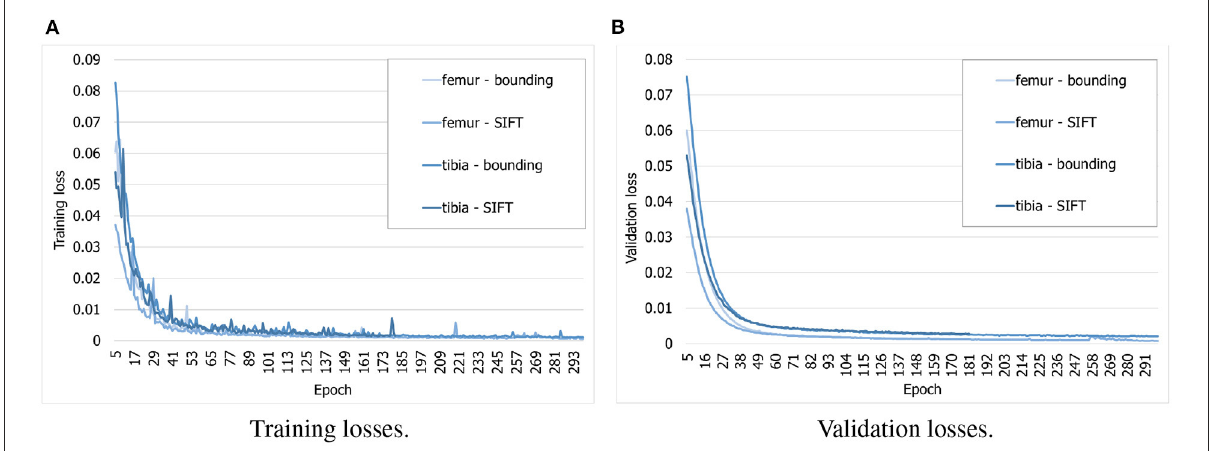
FIGURE8 Evolution of training and validation losses over training epochs. All the losses decrease stably and plateau at the final epochs. (A) Training losses. (B) Validation losses.